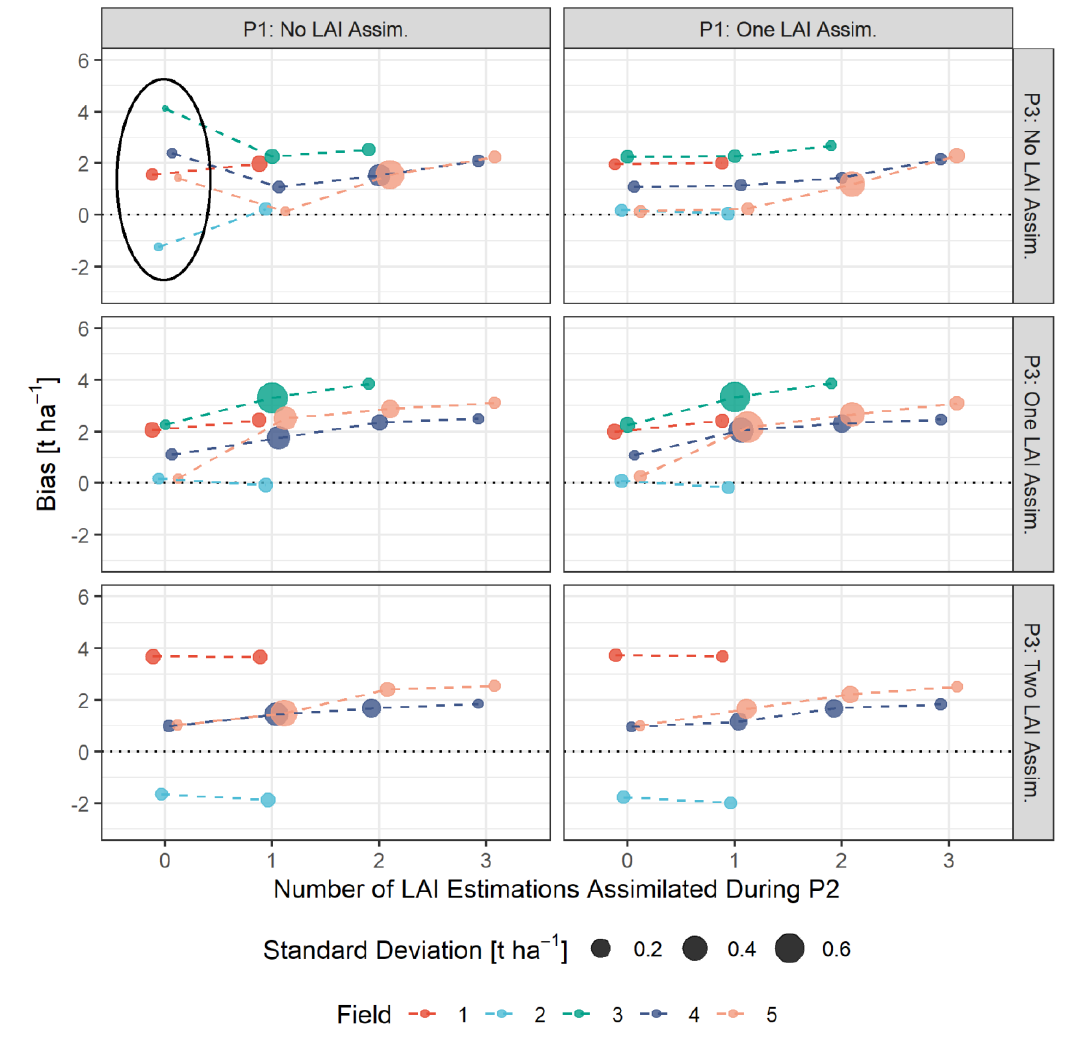
Figure 6. Mean Bias of total aboveground biomass prediction for fields 1–5. Matrix of panels defined by the number of LAI estimations assimilated during phenophase 1 (P1, columns) and the number